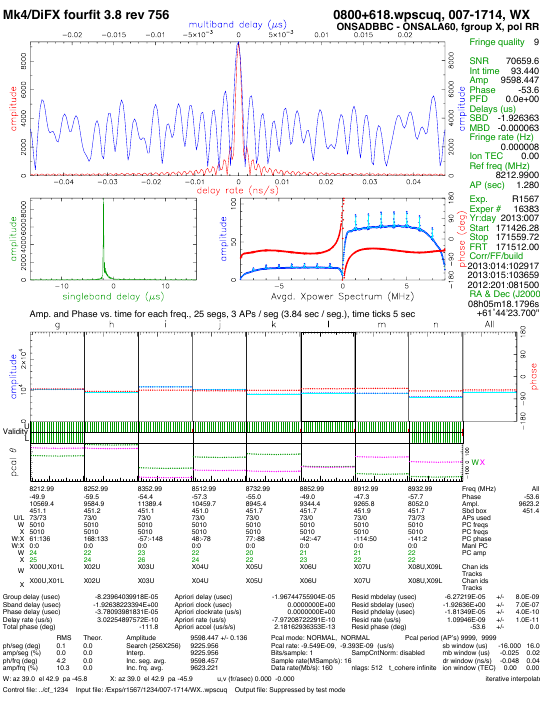
Figure 1: Fringe plot on X-band for the session R1.567 zero-baseline test done with DiFX. The station names, ONSADBBC and ONSALA60, correspond to Od an On, respectively.